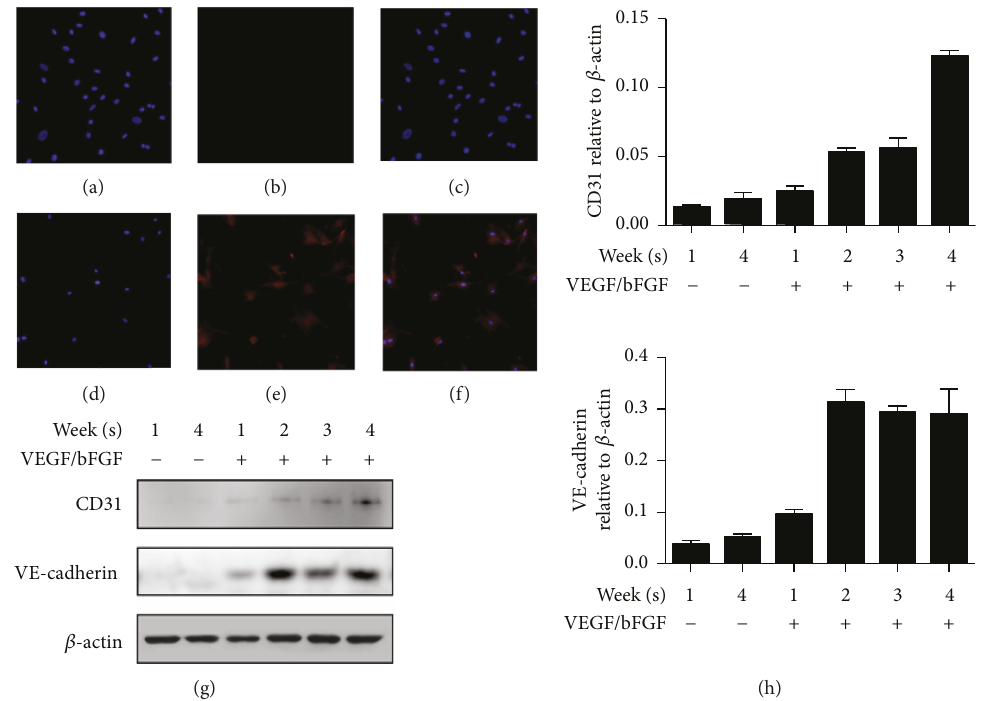
Figure 3: E ff ects of growth factor on endothelial cell-related protein expression by immunocytochemistry and Western blotting. The endothelial-like cells were negative in CD31 after 1 week (a – c) and positive in 1 month (d – f). The protein levels of CD31 and VE- cadherin increased in the growth medium (g). The mRNA expression levels of CD31 and VE-cadherin increased in the growth medium.